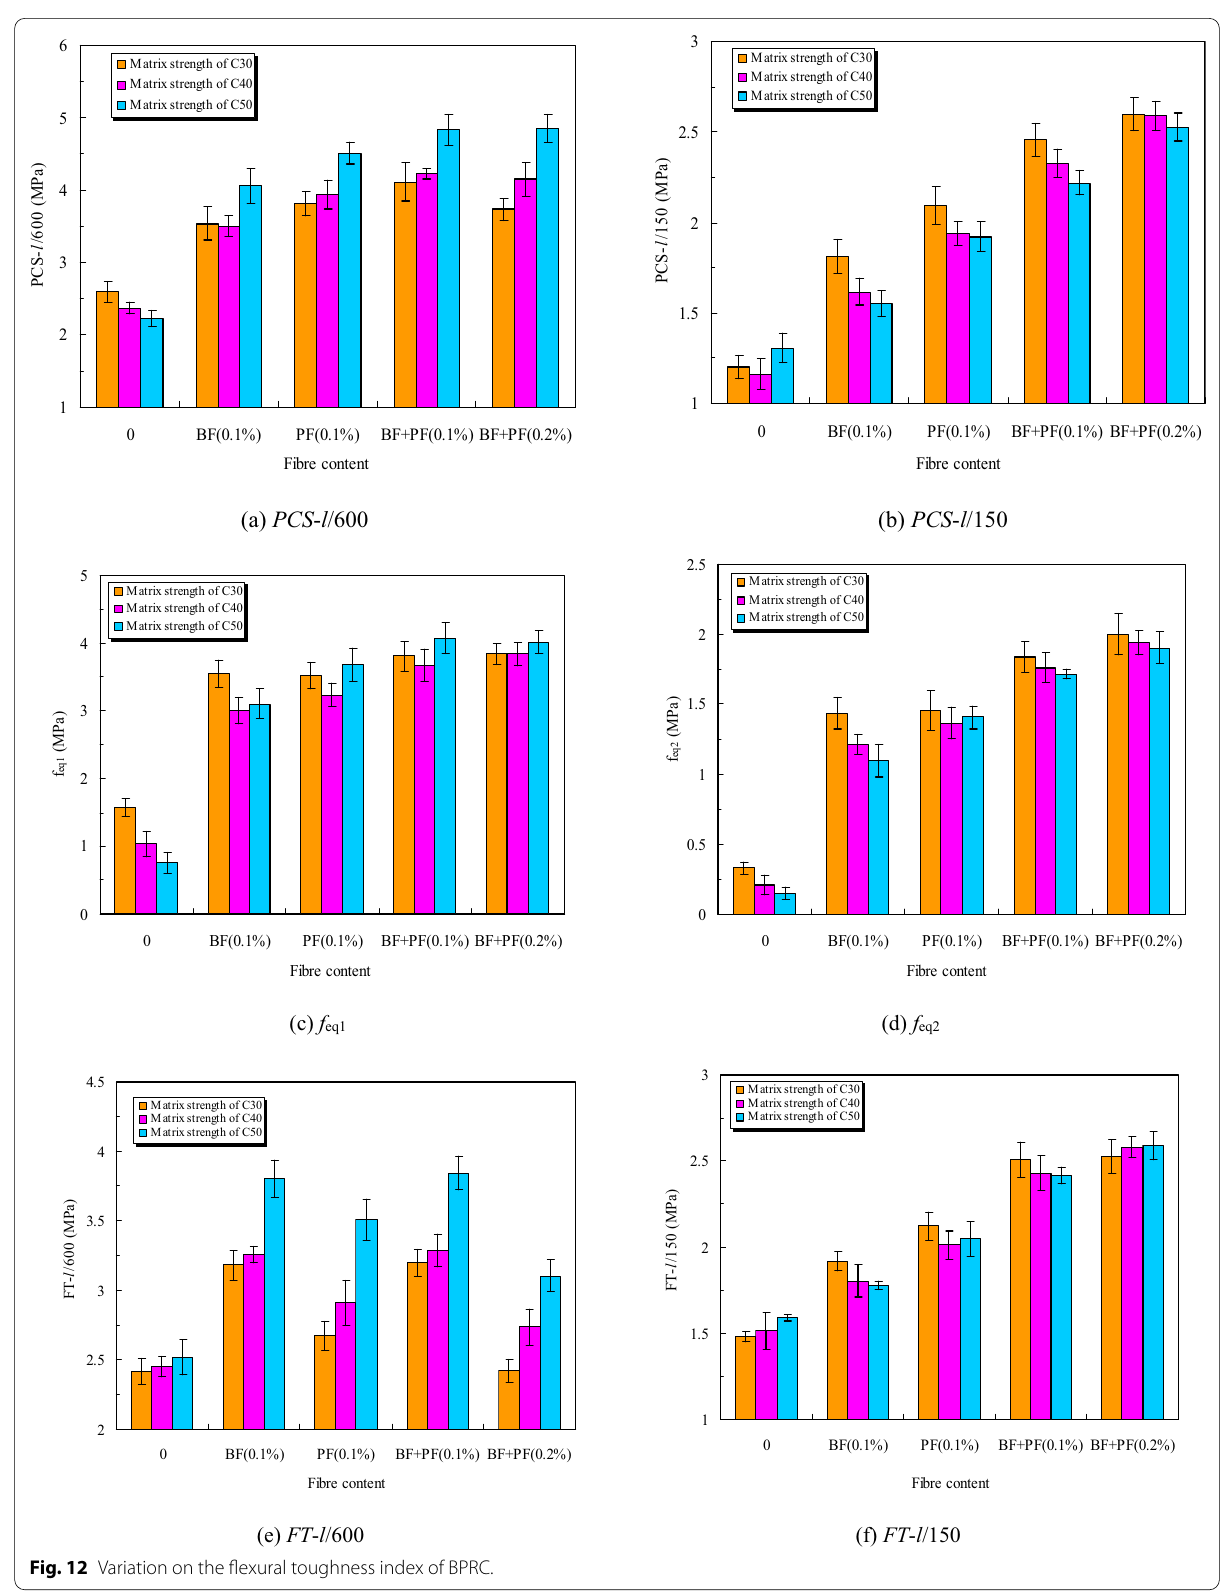
Fig. 12 Variation on the flexural toughness index of